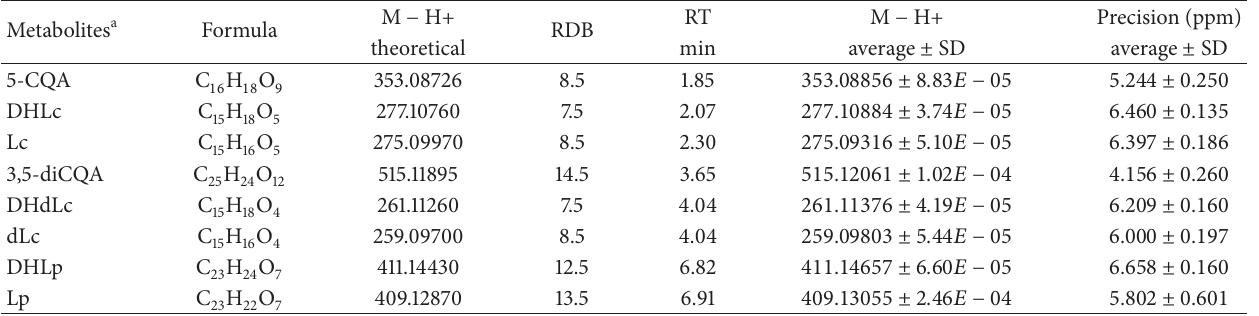
Table 2: Authentication of CGA and STL in chicory flour by negative-ion UPLC-HRMS analysis. Metabolites a